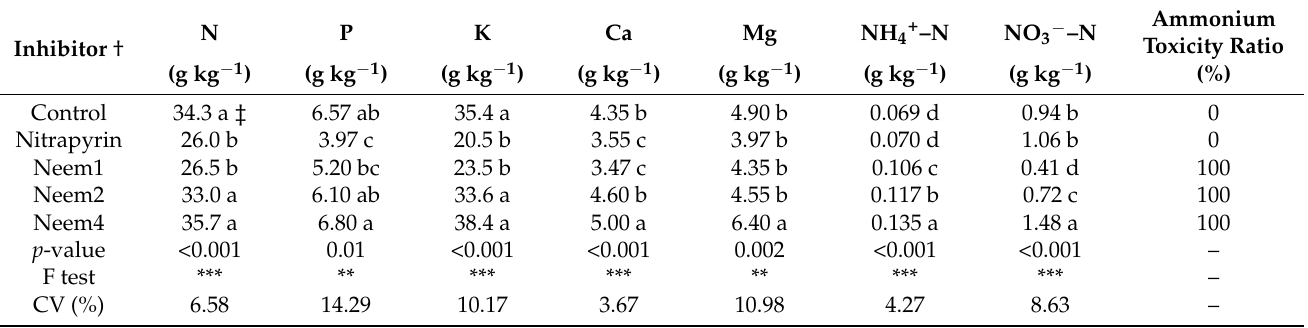
Table 4. Lettuce shoots tissue macronutrients and ammonium and nitrate contents as well as ammo- nium toxicity ratio as affected by different nitrification inhibitors.